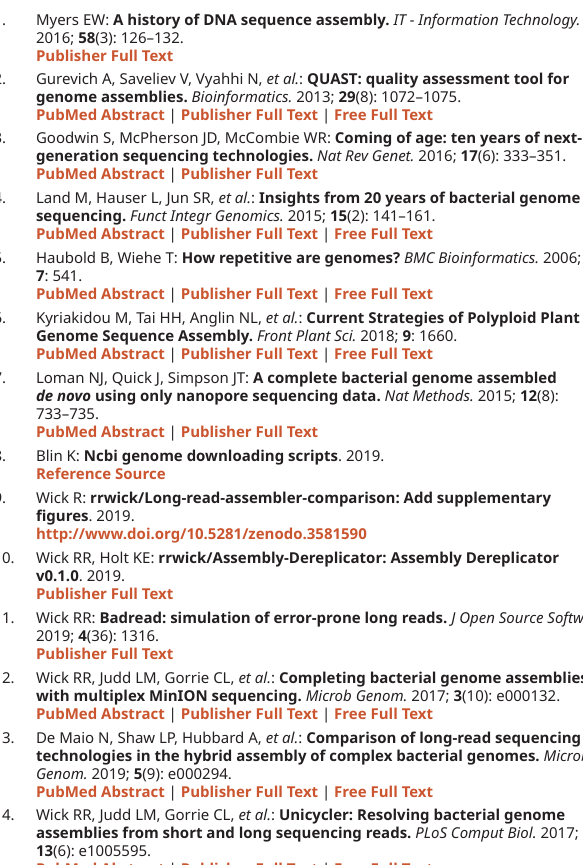
• Figure S9. Plasmid completion for the real read set assemblies for each of the tested assemblers, plotted with plasmid length and read depth. Solid dots indicate completely assembled plasmids (contiguity ≥ 99%) while open dots indicate incomplete plasmids (contiguity <99%). Percentages in the plot titles give the proportion of plasmids which were completely